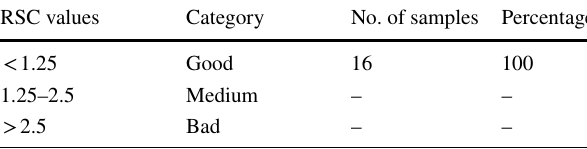
Table 5 Classification based on RSC values (Richards 1954)